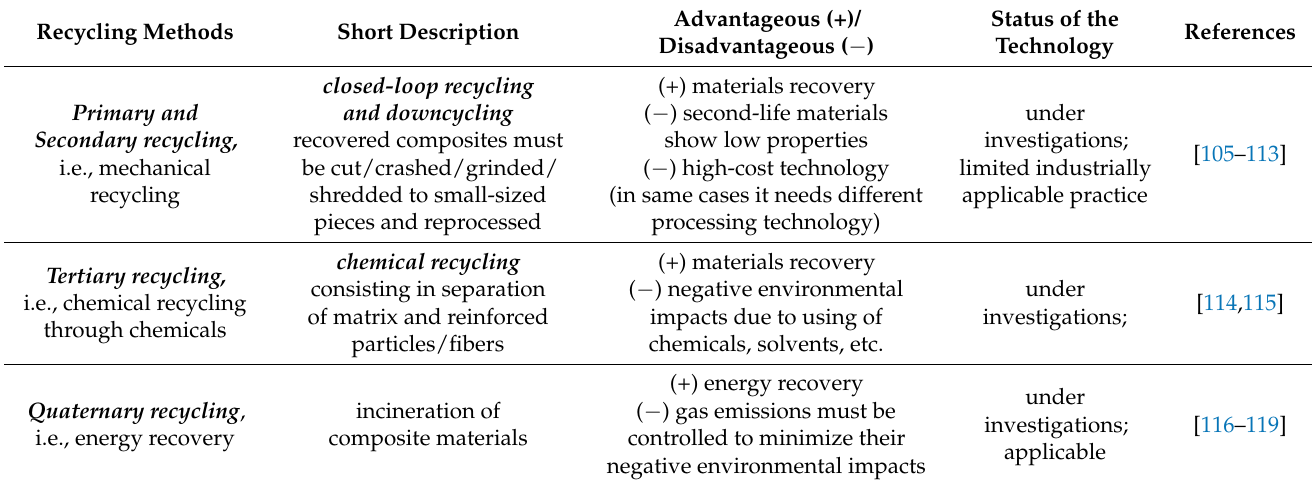
Table 3. Overview of recycling methods for thermoplastic and thermoset